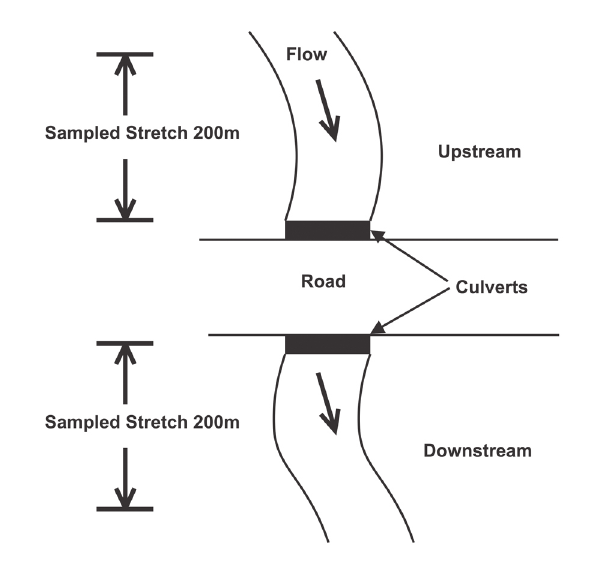
Fig. 3. Diagram showing the design of fish sampling in the